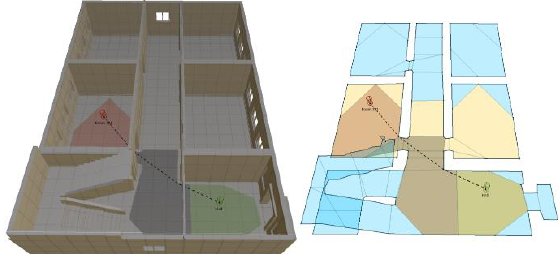
Figure 12 Indoor path planning from “Hall” to “Room 101”